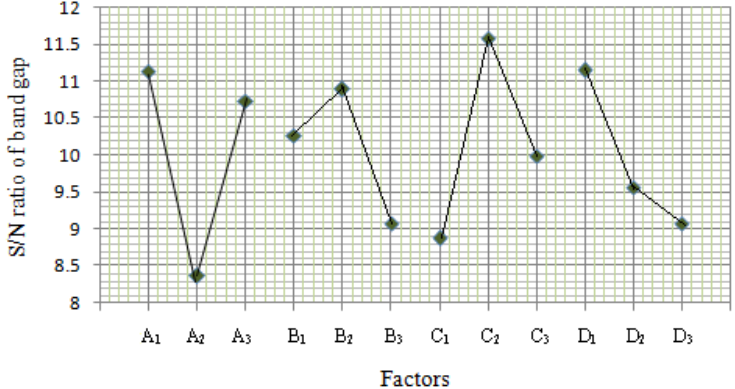
Figure 3. Analysis of effects of control parameters and interaction on S/N for energy band gap.